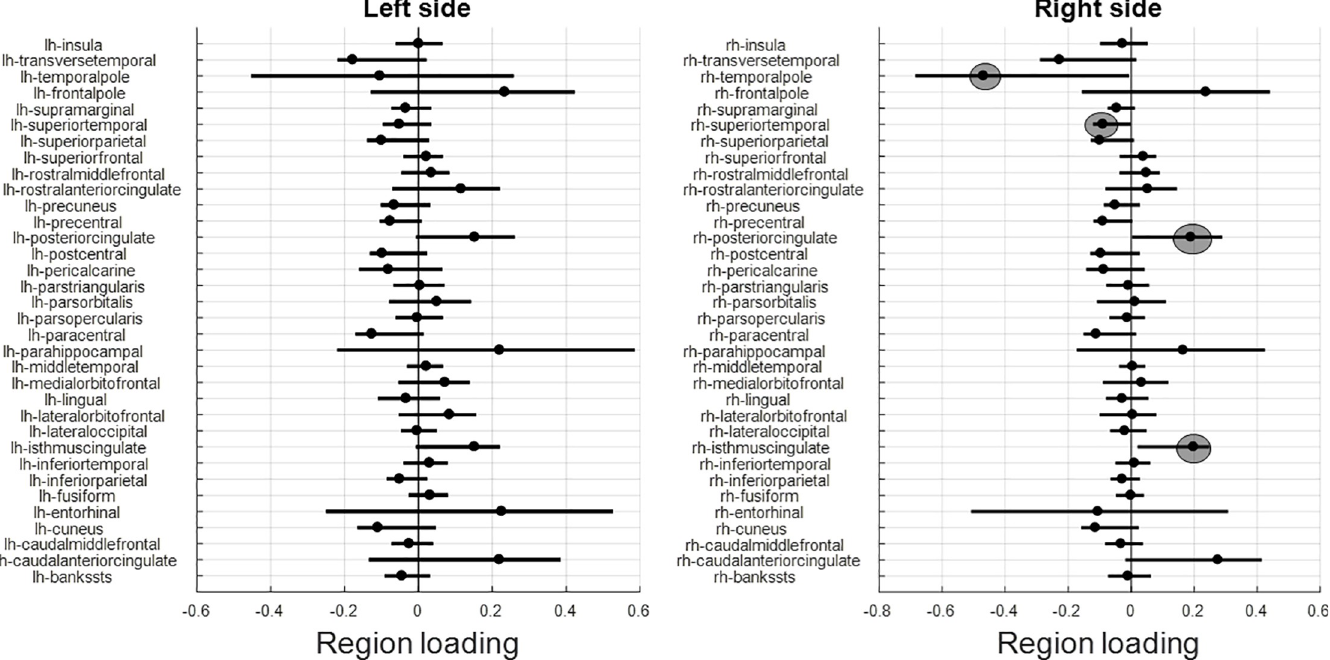
Fig 4. 95% coverage intervals, i.e. from 2.5%ile to 97.5%ile, plotted for all regional loadings by bootstrap procedure with 10,000 iterations. Left panel: left-side side regions; right panel: right-side regions. The regions whose 95%-coverage intervals did not include the zero point were circled in gray color.